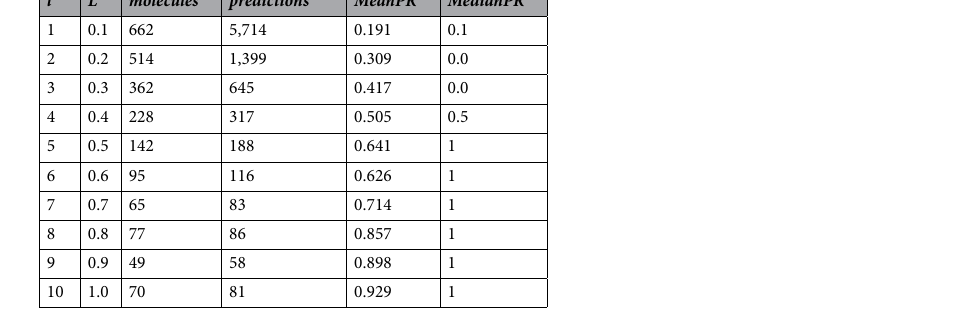
Table 5. Performance results for the best method (quantification of results from Fig. 2). The mean and median values for precision (PR) are shown, as well as the number of query molecules with a given l